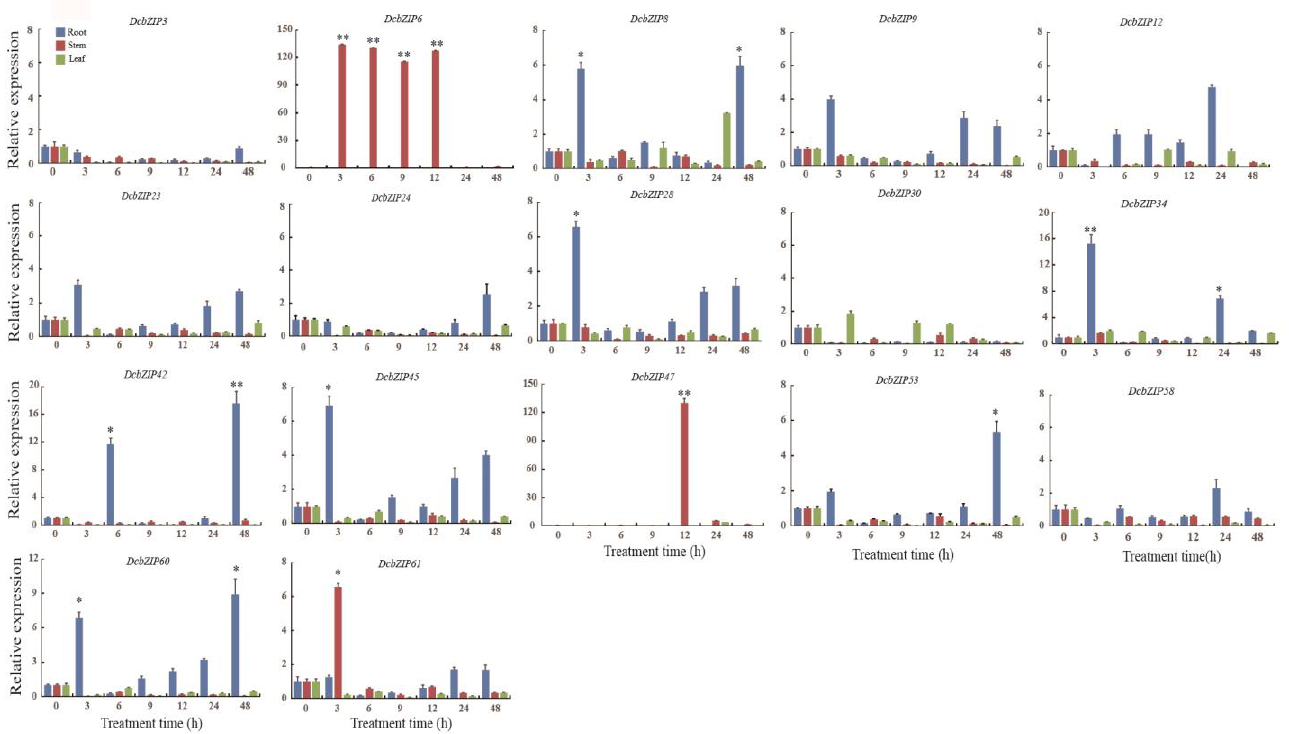
Figure 8. Real-time quantitative PCR analyses of the 17 core DcbZIP genes under drought stress in roots, stems and leaves. The mean expression value was calculated from three replicates. Vertical bars indicate the standard deviation. Values of 0, 3, 6, 9, 12, 24 and 48 indicate hours after treatment. Mean values and standard deviations were calculated according to the data. The unstressed level (0 h) was used as a control. Asterisks (* or **) indicate a significant difference at p < 0.05 or p < 0.01, respectively.